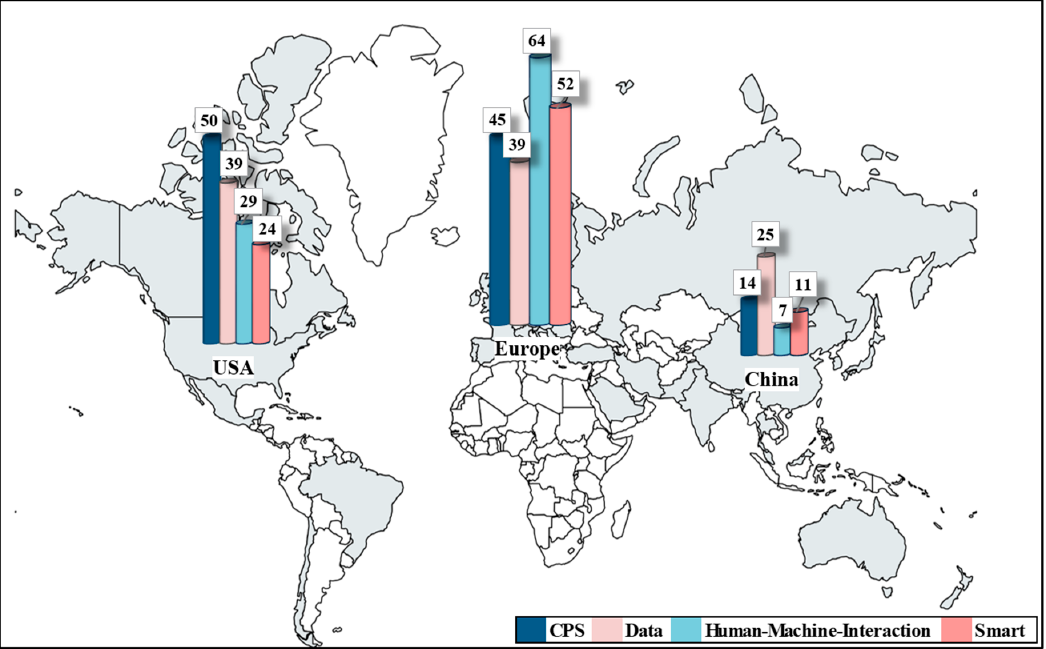
Figure 3. Number of papers identified in the uncorrelated international analysis (worldwide scale). Sources of the shapefile: [38,39].